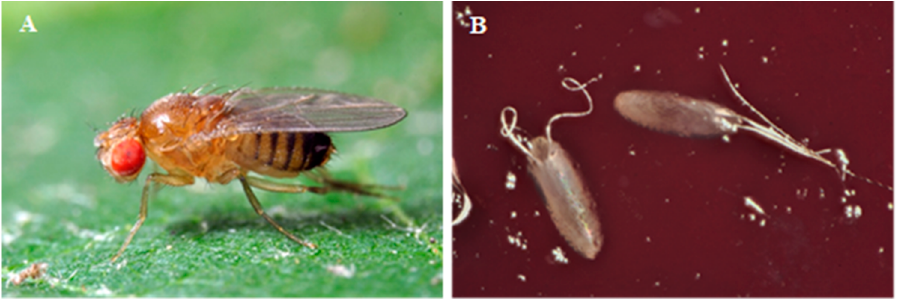
Figure 1. ( A ) Female of Drosophila suzukii lateral view. ( B ) D. suzukii eggs laid on a mock fruit.